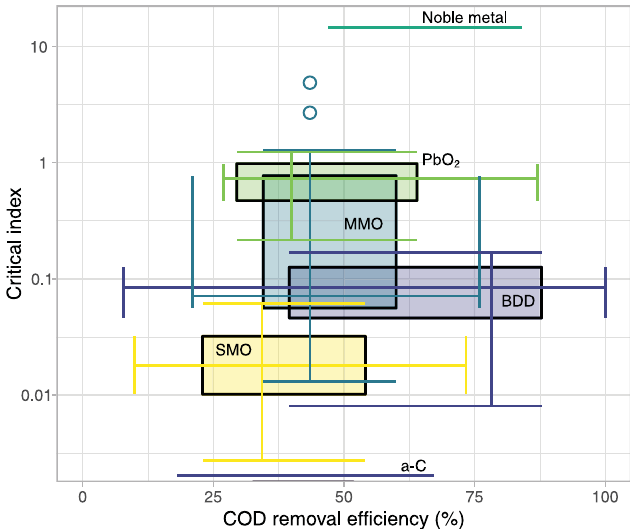
Fig. 6. Correlation between the material critical index and COD removal ef fi ciency.